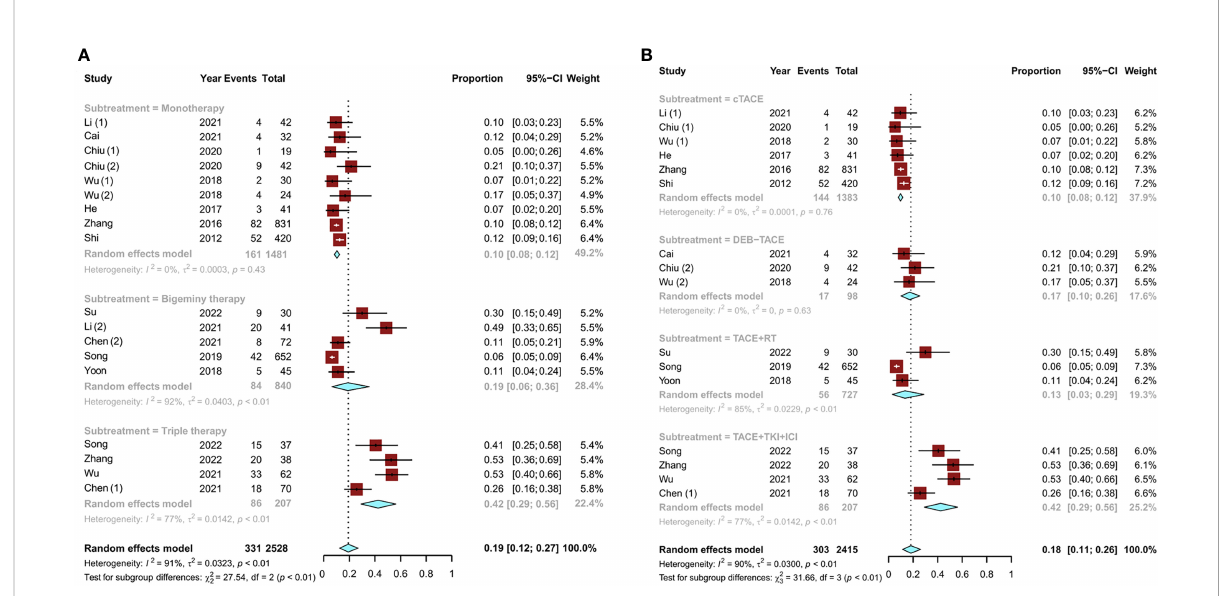
FIGURE 2 Pooled analysis of the conversion rate of uHCC: (A) TACE monotherapy and TACE combination therapy (bigeminy therapy or triple therapy) and (B) subgroup analysis of different combination therapies (cTACE, DEB-TACE, TACE combined with RT, and TACE in combination with TKIs and ICIs). uHCC, unresectable hepatocellular carcinoma; cTACE, conventional transarterial chemoembolization; DEB-TACE, drug-eluting beads transarterial chemoembolization; RT, radiotherapy; TKIs, tyrosine kinase inhibitors; ICIs, immune checkpoint